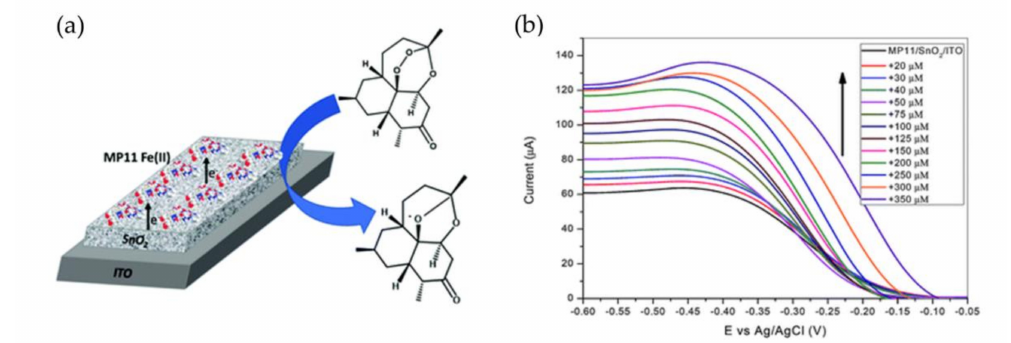
Figure 7. Artemisinin (ART) sensing by MP-11 on mesoporous SnO 2 . ( a ) Schematic representation of MP-11 immobilized on didodecyldimethylammonium bromide (DDAB) modified SnO 2 film electrodes causing the electrocatalytic reduction of ART. ( b ) DPVs of the sensor after the addition of increasing ART concentrations in 10 mM NaH 2 PO 4 pH 7 bu ff er at a scan rate 0.1 V s − 1 . Reprinted from Ioannidis et al., 2019 [146]. Published by the Royal Society of